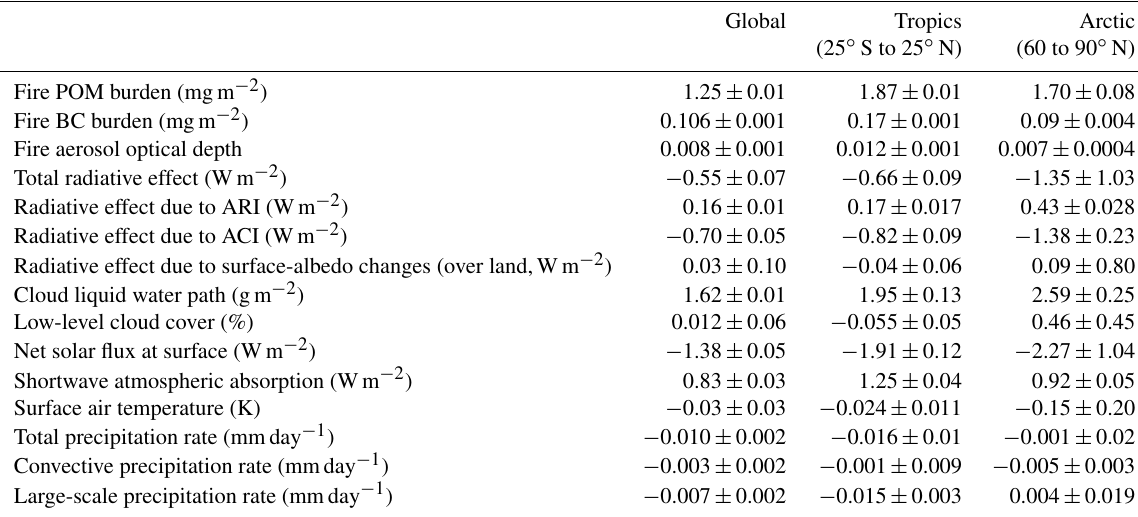
Table 2. Global, tropics (25 ◦ S to 25 ◦ N) and Arctic (60 to 90 ◦ N) annual mean fire aerosol (POM and BC) burdens, fire aerosol AOD, total fire aerosol radiative effect (RE) at TOA, radiative effects due to aerosol–radiation interactions (REari), due to aerosol–cloud interactions (REaci), surface-albedo changes (REsac) and changes in cloud liquid water path (LWP), low-level cloud cover, net solar fluxes at the surface, shortwave atmospheric absorption, surface air temperature and precipitation (total, convective and large scale) due to all fire aerosols. Standard deviations about the 10-ensemble means are